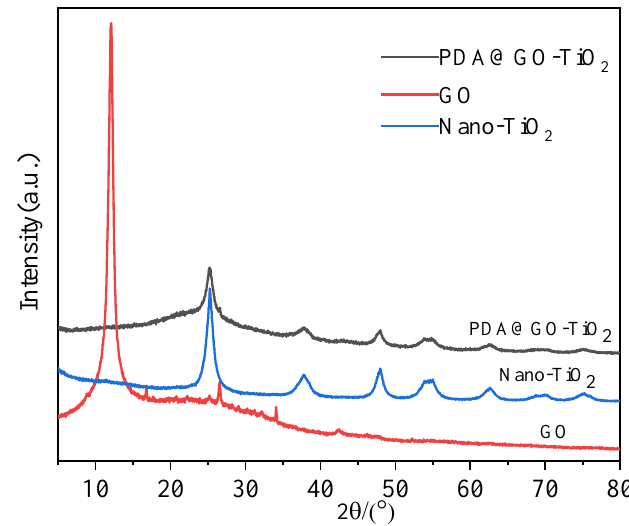
Figure 4. X-ray diffraction (XRD) patterns of Nano-TiO 2 , GO, nano-PDA@GO-TiO 2 composites.